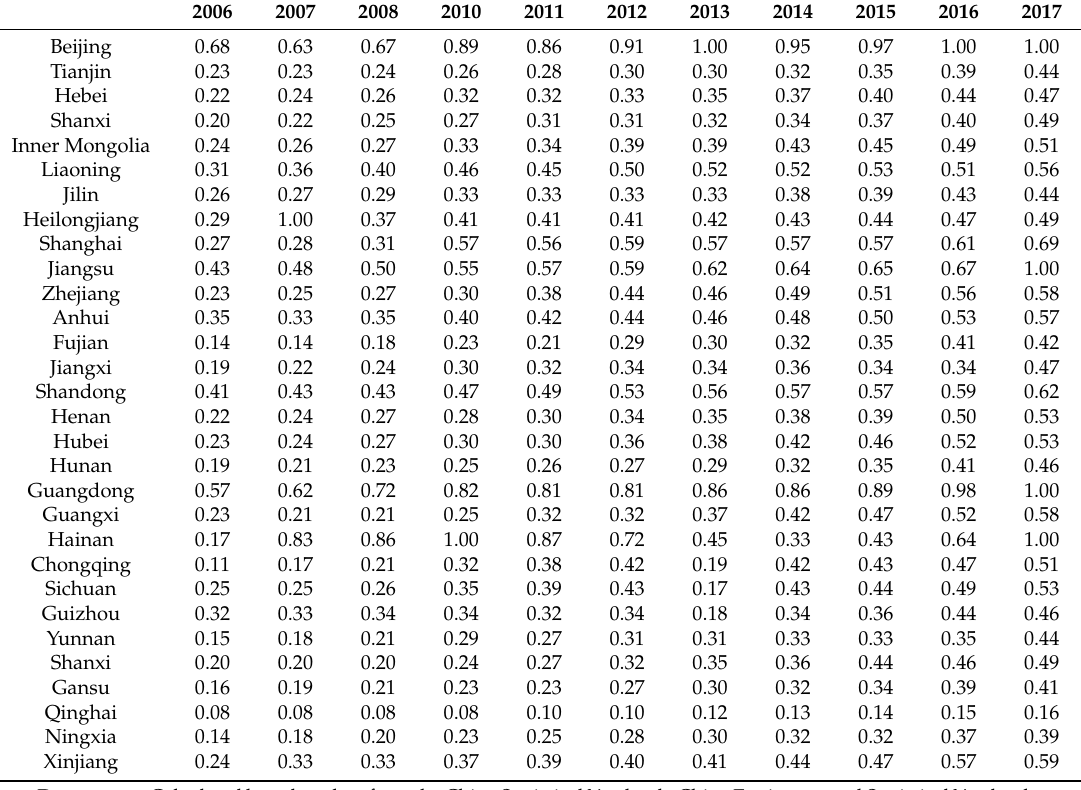
Table 2. The high-quality development of regional economic in China’s provinces from 2006 to 2017.